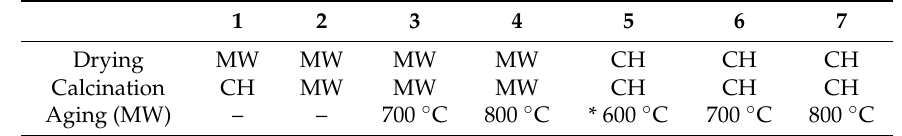
Table 1. Summary of 1 wt% Pt/Al 2 O 3 samples